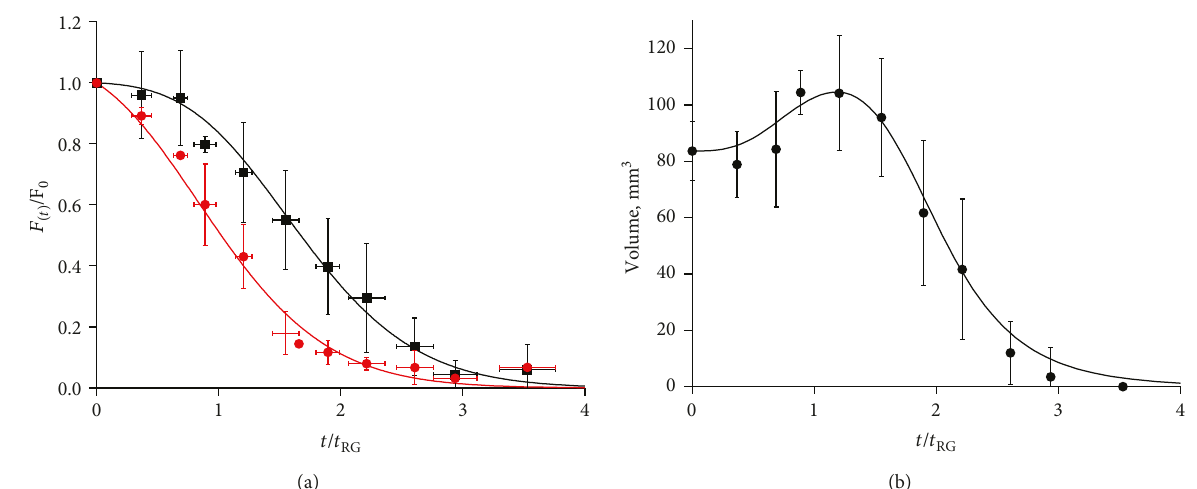
fl uorescence ( F / F Figure 6: Loss of gel components as a function of t RG . (a) Fractional t 0 ) remaining at the injection site as a normalized function of t / t RGin vitro for 13 di ff erent hydrogel microspheres having t RG values ranging from 12 to 2750 hours and f = 0 21 (black square) or f = 0 45 (red circle). The data were grouped into clusters having a median of t / t RGin vitro ± 0 2 , and vertical lines show the mean ± standard deviation of the measured parameter within each cluster. Theoretical curves were calculated according to equation 3 where N = 6 and t = 1 36 · t max 1/2,L2 RGin vitro . (b) Fit of the clustered ultrasound volumes of materials E-M (Table S1) to equation 4 using 83 5 mm 3 and Q = 1 5 . Error bars represent the standard deviation of the clustered volume